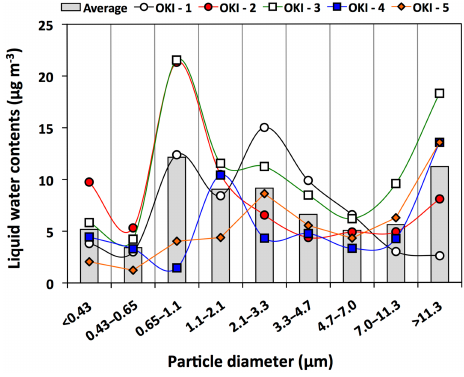
Figure 7. Aerosol liquid water contents for each sample in size- segregated aerosols and average liquid water contents in size- segregated aerosols on Okinawa